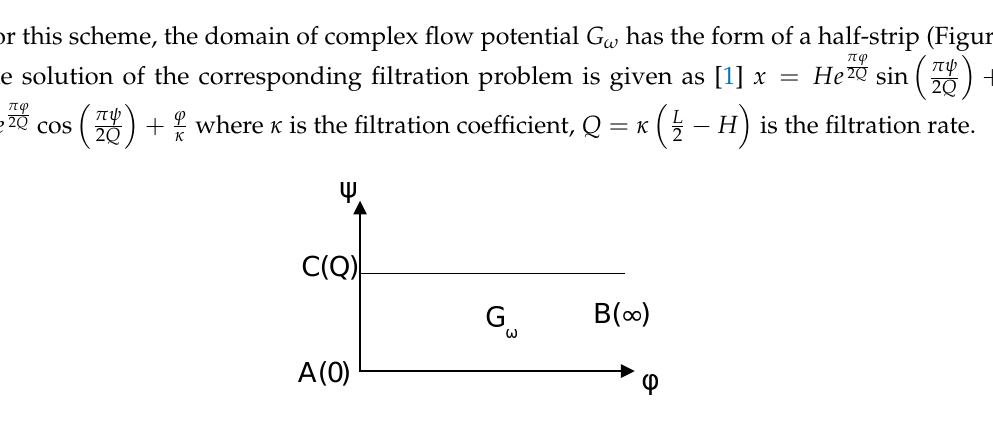
Figure 2. Scheme of filtration in the domain of complex flow